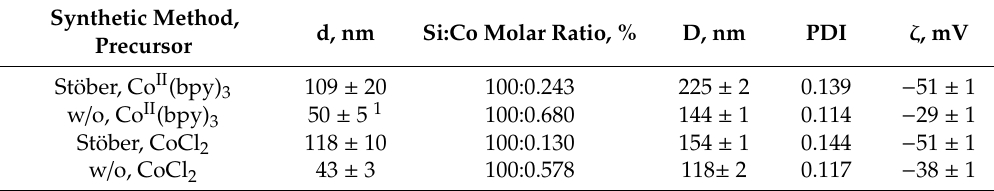
Table 2. Average diameters (d) in dried samples (TEM), Si:Co molar ratio (ICP-OES), average hydrodynamic diameters (D), polydispersity index (PDI) and zeta potential values ( ζ ) (DLS) in aqueous